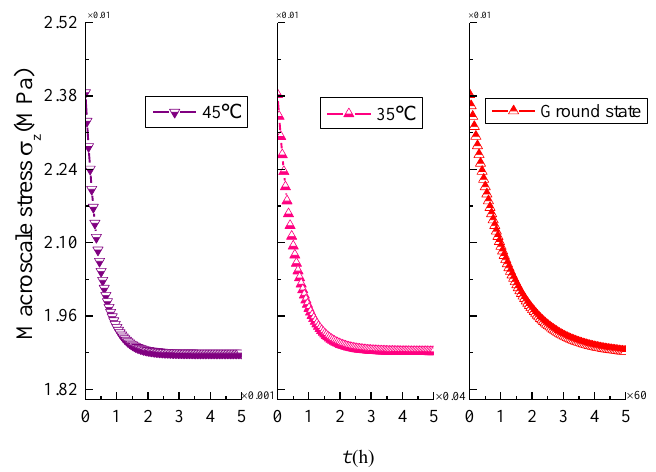
 under different temperatures. z